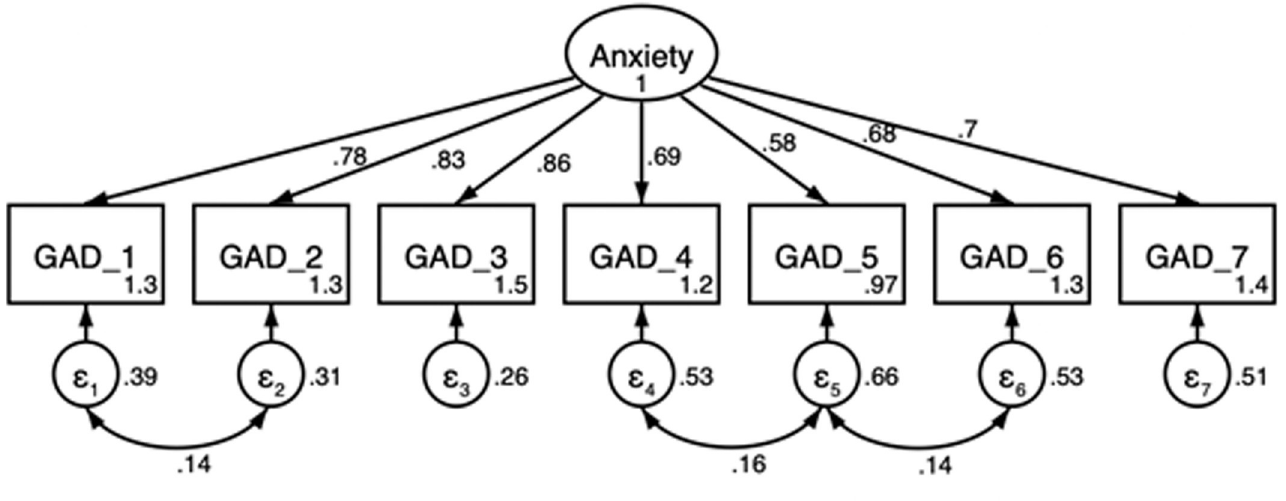
Fig 2. Confirmatory factor analysis path diagram for modified one-factor model of GAD-7